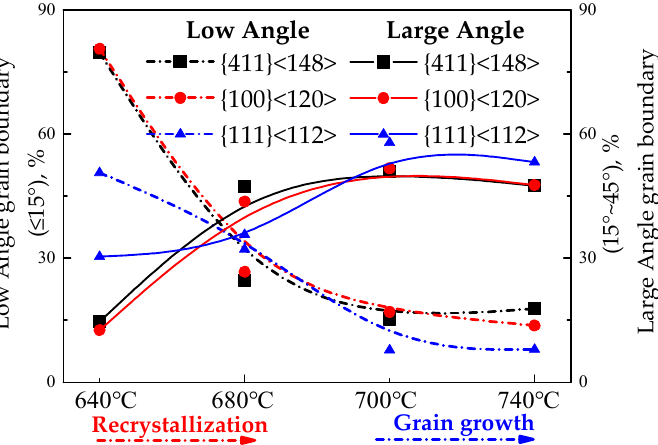
Figure 13. Distribution of orientation difference between {100}<120>, {111}<112> and {411}<148> tex- tures and their adjacent grains of CSP process Fe-0.65%Si non-oriented electrical steel annealed sheets.